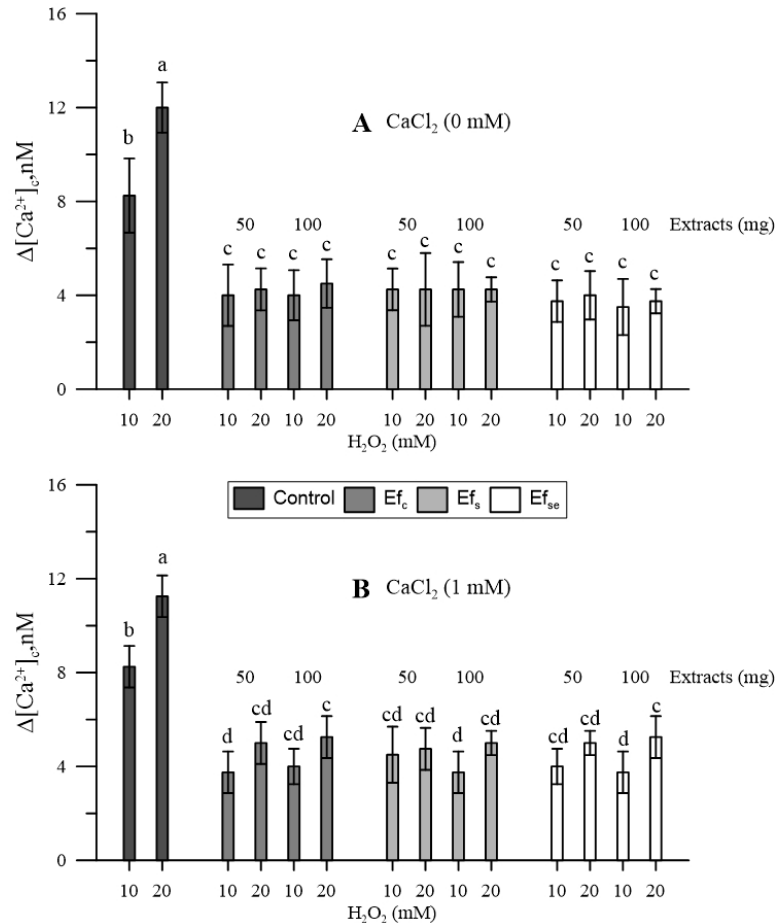
Figure 3. Effects of H 2 O 2 (10 and 20 mM) on the cytosolic Ca 2+ of maize pollen pre-treated with 50 or 100 mg of free extracts of emmer wheatgrass grown with distilled water as a control (Ef c ), or in the presence of salinity as NaCl 50 mM (Ef s ) or selenium as 45 mg L − 1 of Na 2 SeO 3 (Ef Se ). Maize pollen was ( A ) in the absence or ( B ) in the presence of 1 mM CaCl 2 in the growing medium. All analyses were performed in triplicate. Data are expressed as means ± SEM from four independent tests. Different letters indicate significant differences for p < 0.05.